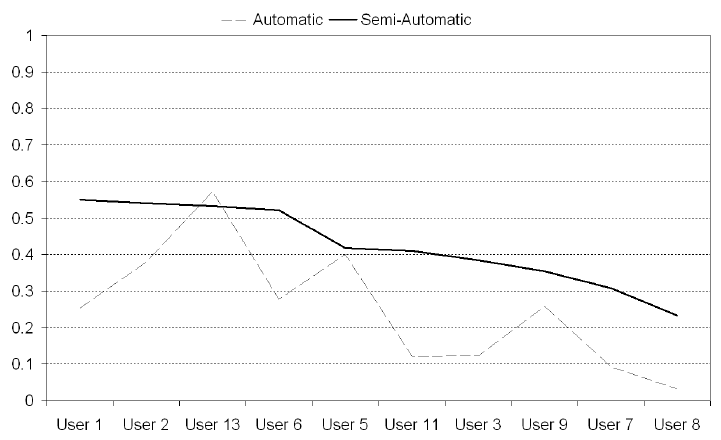
Figure 13. Effectiveness of (semi-) automated runs on each user.